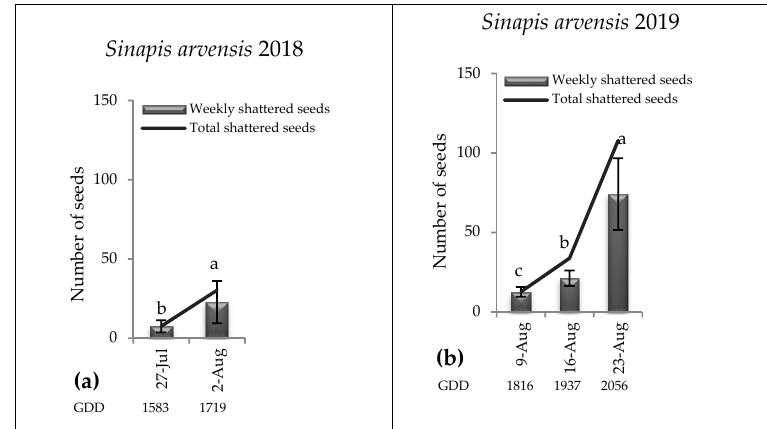
Figure 4. Average weekly and cumulative seed shedding per plant of Sinapis arvensis in ( a ) 2018 and ( b ) 2019 during the growing season of spring oat. GDD = Growth Degree Days = sum of daily mean temperatures above 0 from the date the oat was sown . Columns with di ff erent letters are statistically di ff erent at the 0.05 probability